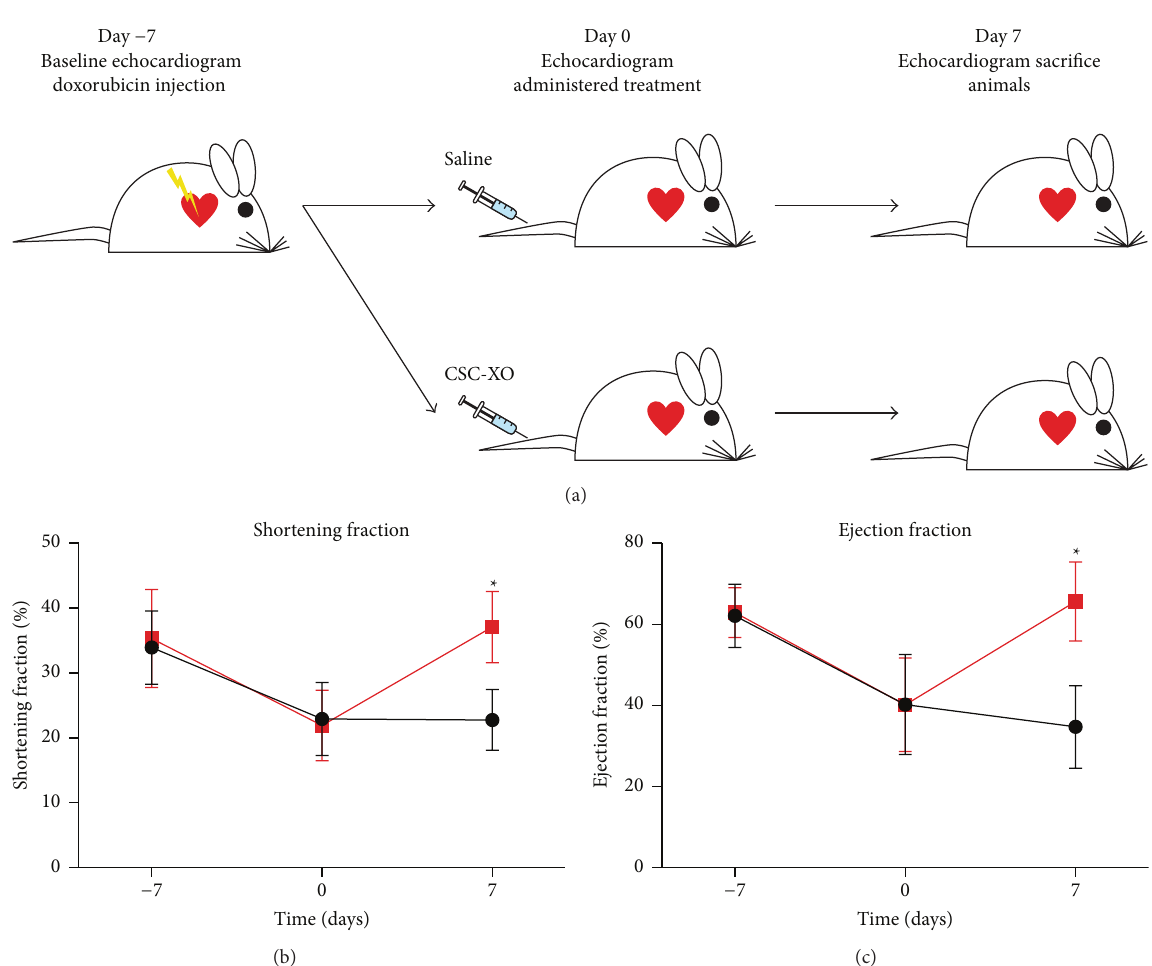
Figure 4: (a) Outline of the in vivo portion of the study. Heart function analysis showing both the (b) shortening fraction and (c) ejection fraction. Both measurements of heart function showed improvement in the CSC-XO treated groups 7 days following CSC-XO injection.